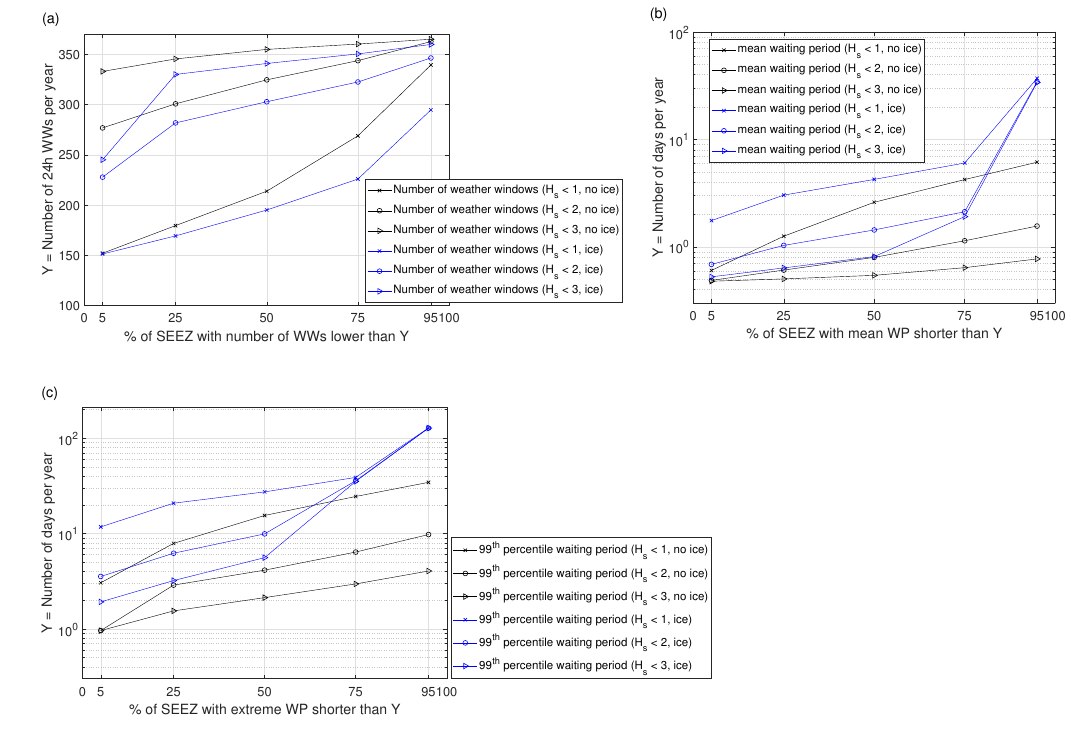
Figure 10. The number of 24 h weather windows (in ( a )), length of mean waiting periods (in ( b )), and 99th percentile waiting periods (in ( c )) shown as a function of the spatial percentile for the SEEZ, indicating how many percentage points of the region that have the considered number of weather windows and length of waiting periods. Different significant wave height limits are used together with assumptions that ice conditions are considered as inhibiting (blue lines) or not (black lines) for the assessment of weather